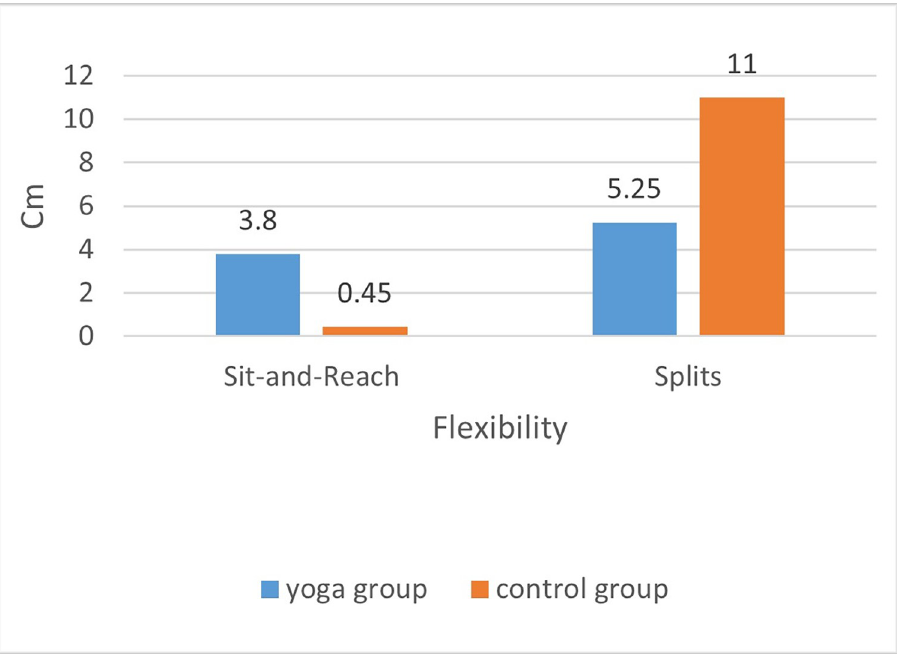
Fig 7. Posttest comparison of flexibility. � The smaller the value of the Splits was, the better the flexibility of the groin, hip, and